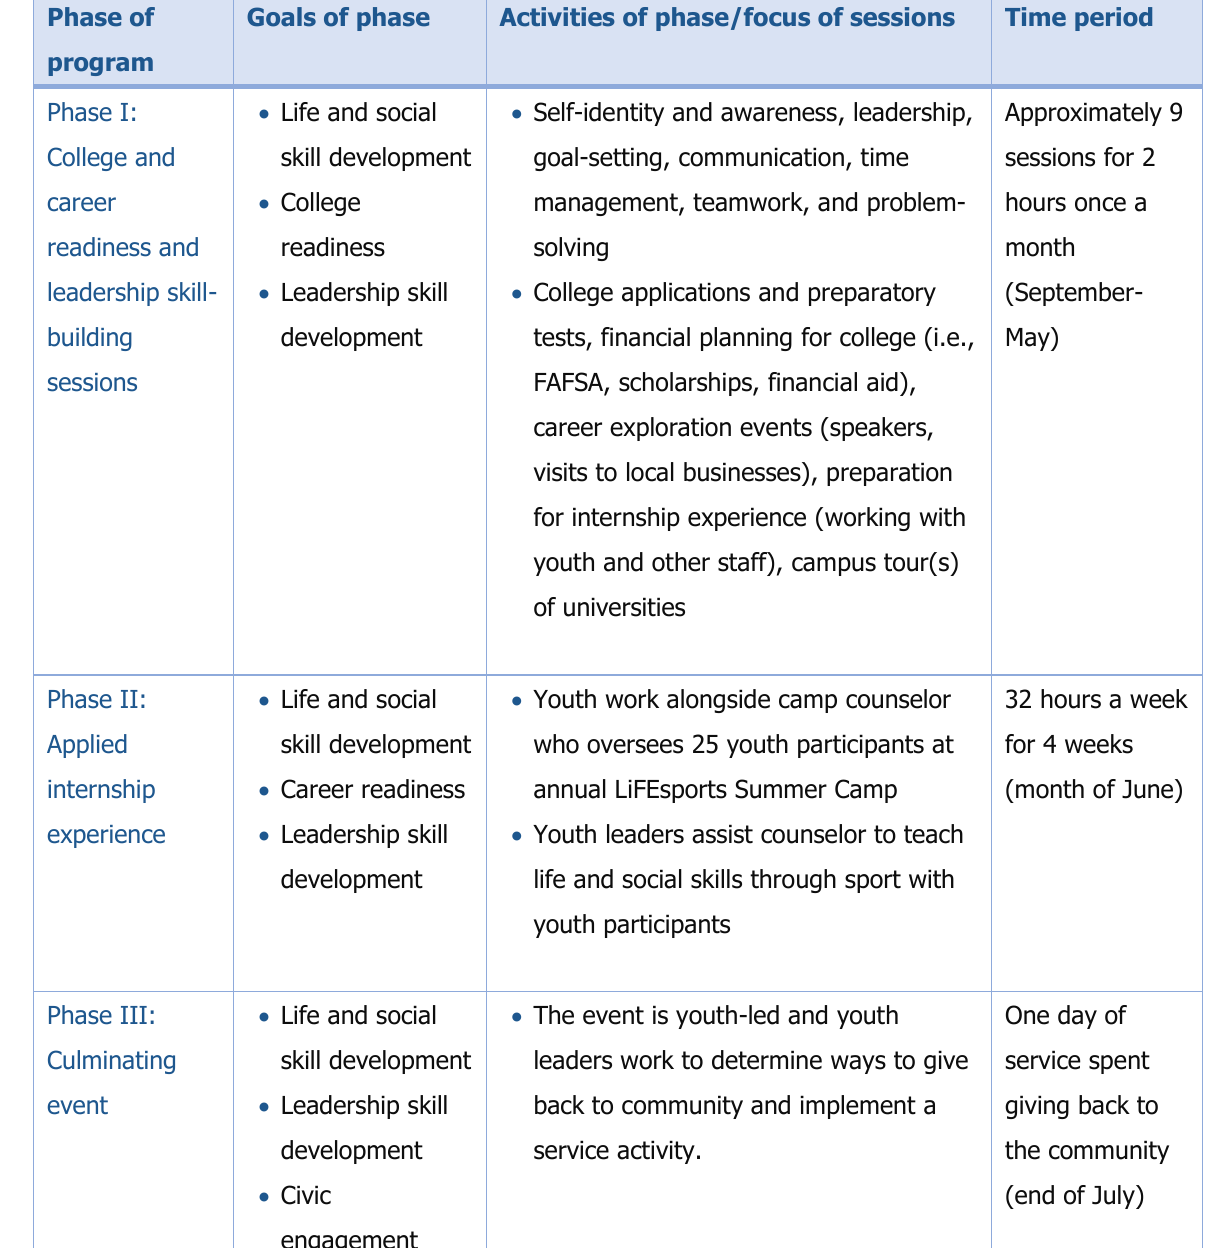
Table 1. YLA Program